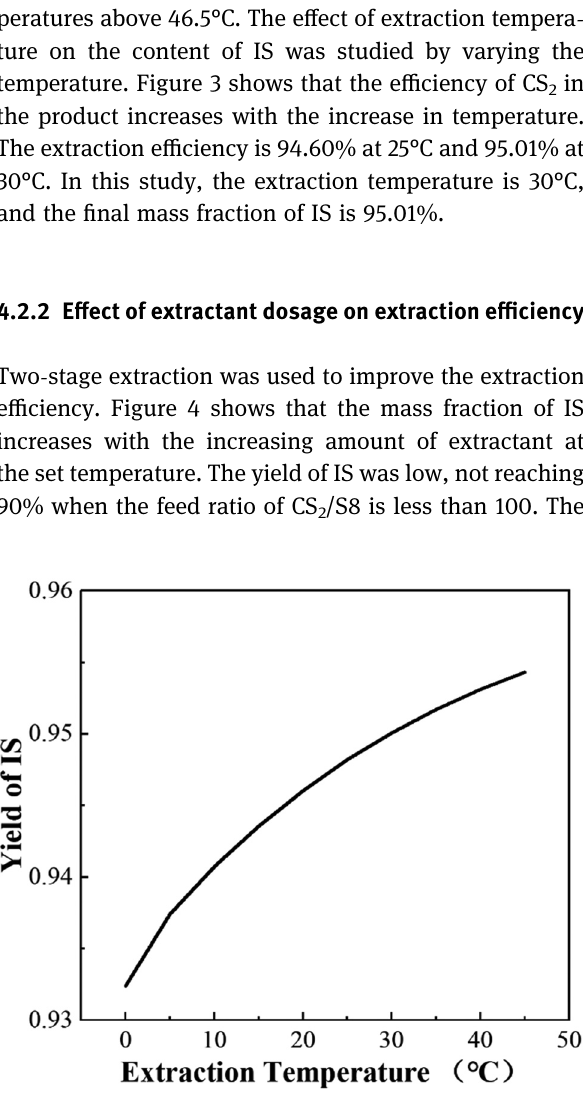
Figure 3: Relationship between the extraction temperature and the IS